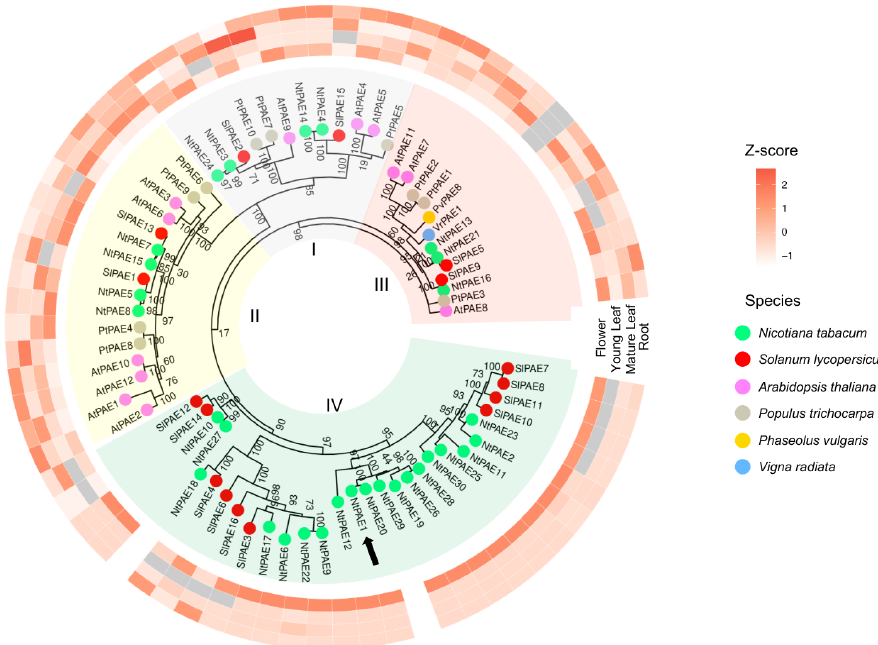
Figure 2. Maximum likelihood phylogenetic tree of PAE proteins and their expression levels in different plant tissues. The circles on the tree tips represent the species of each sequence, according to the legend on the right. Numbers close to the nodes represent the percentage of bootstrap replicates (out of 1000) that support them. Green-shaded highlight: clade IV, represented exclusively by Solanaceae PAEs, which are preferentially expressed in flowers. Black arrow: NtPAE1. Yellow-shaded highlight: clade II; Blue shaded highlight: clade I; Red shaded highlight: clade III. The expression levels of PAEs, represented as z-scores, are shown in the matrix above their corresponding PAE, for four different tissues—roots, young leaves, mature leaves, and flowers. Gray squares in the expression matrix represent missing